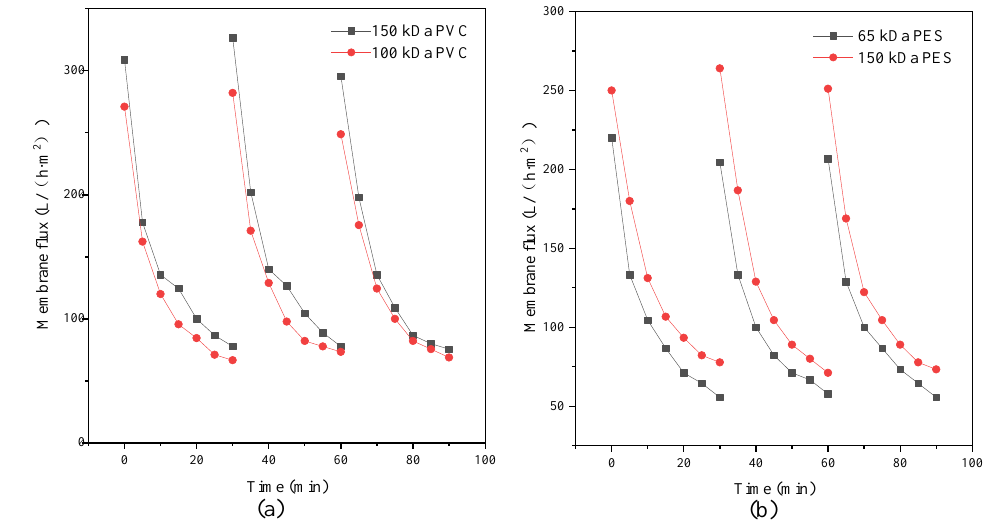
Figure 4. Variations in membrane flux with time: ( a ) PVC and ( b ) PES.